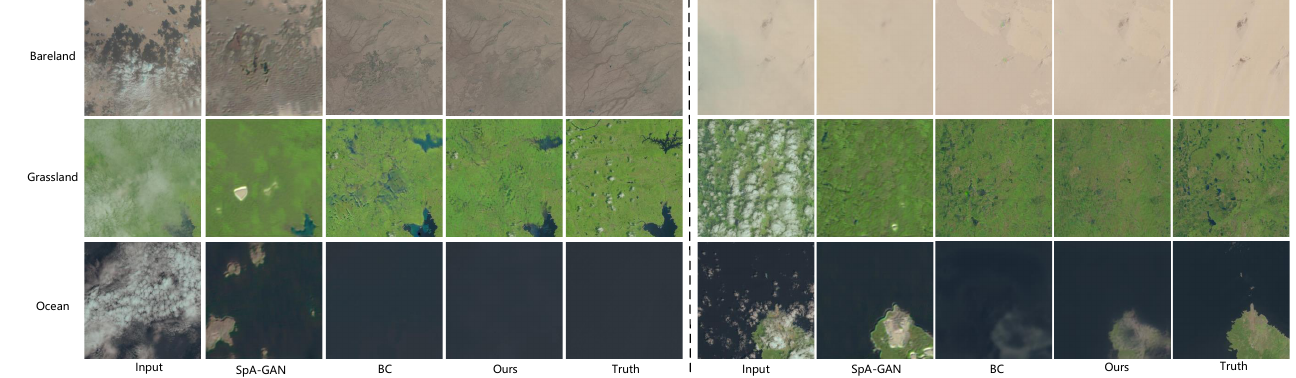
Figure 7. Reconstruction visualization results for removing real data clouds on the RICE-II dataset with SpA-GAN [28], BC [43], and ours. Please zoom in for